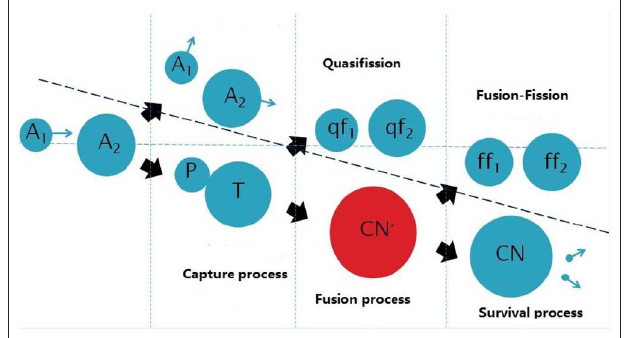
FIGURE 1 | (Color online) Schematic diagram of production of superheavy